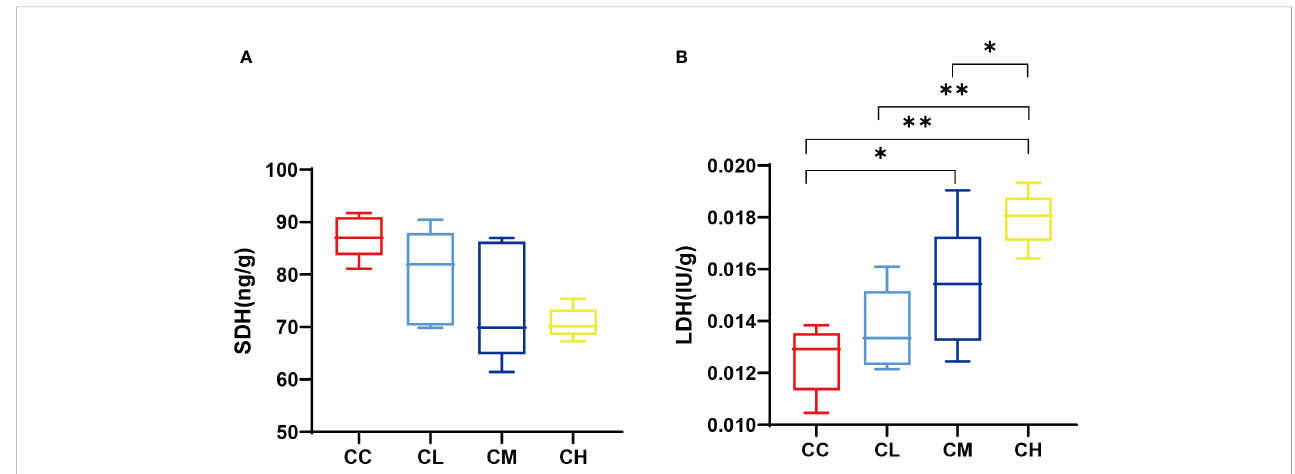
FIGURE 4 muscle SDH and LDH content. (A) SDH content. (B) LDH content. CC: control group, CL: low-dose GFPS group, CM: medium-dose GFPS group, CH: high-dose GFPS group. (* p < 0.05, ** p <